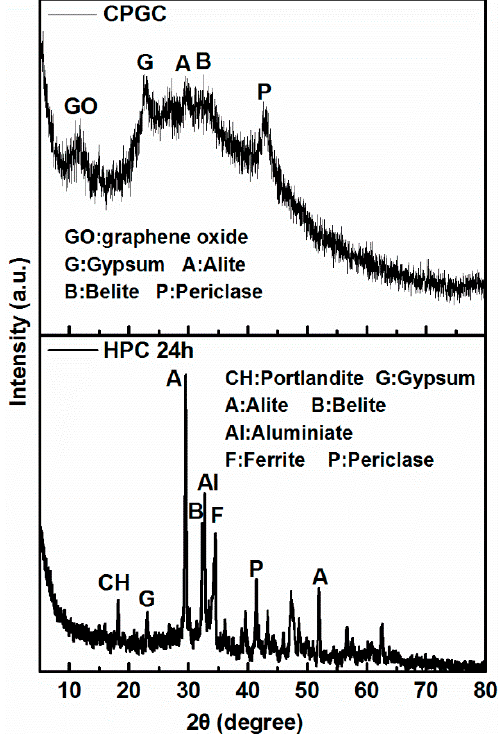
Figure 8. XRD patterns for CPGC and hydration products of cement (HPC).